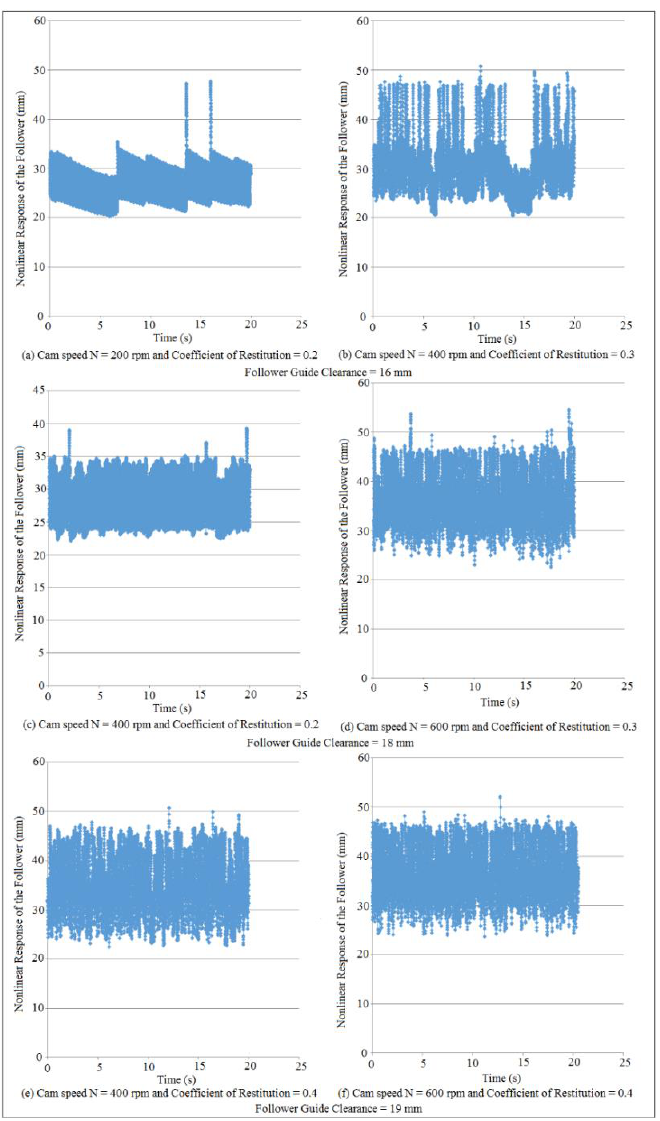
Figure 4. Nonlinear response mapping when the follower offsets to the right (O = 10 mm).